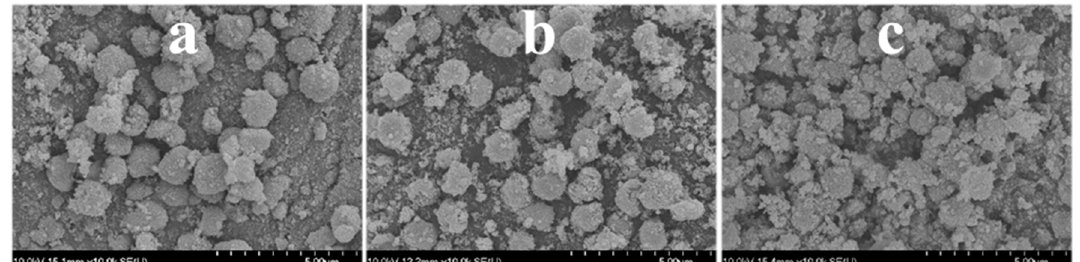
Figure 6. SEM micrographs of the H2_HS_2 ( a ), H2_HS_3 ( b ), and H2_HS_4 ( c ) samples (synthesized by the application of membrane filtered carbon spheres using increasing amounts of acetone/water, respectively) after calcination.